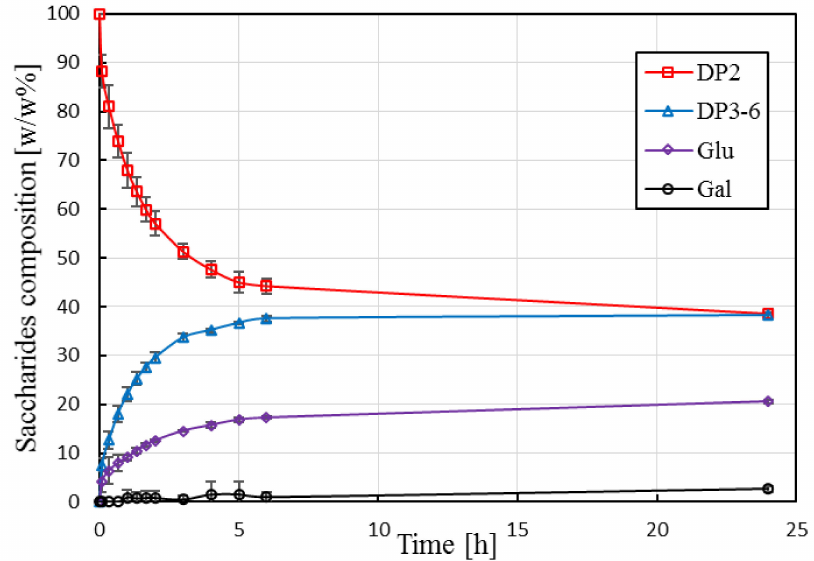
Figure 4. Saccharide composition as function of reaction time in stirred-tank reactor. Operational conditions: 30 g · kg − 1 initial lactose concentration, 19.1 U · g − 1 , pH 6.0, 50 ◦ C, 60 rpm. Mean values and standard deviation of triplicate measurements are shown. Continuous lines are guides for the eye.